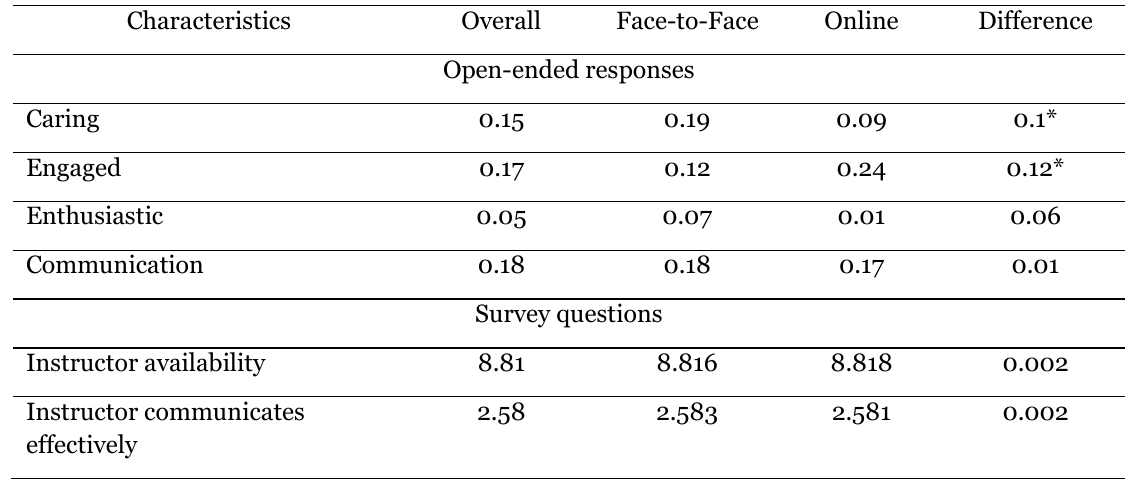
Difference of Means Tests Comparing Worst Face-to-Face and Online Classes: Instructor Characteristics Characteristics